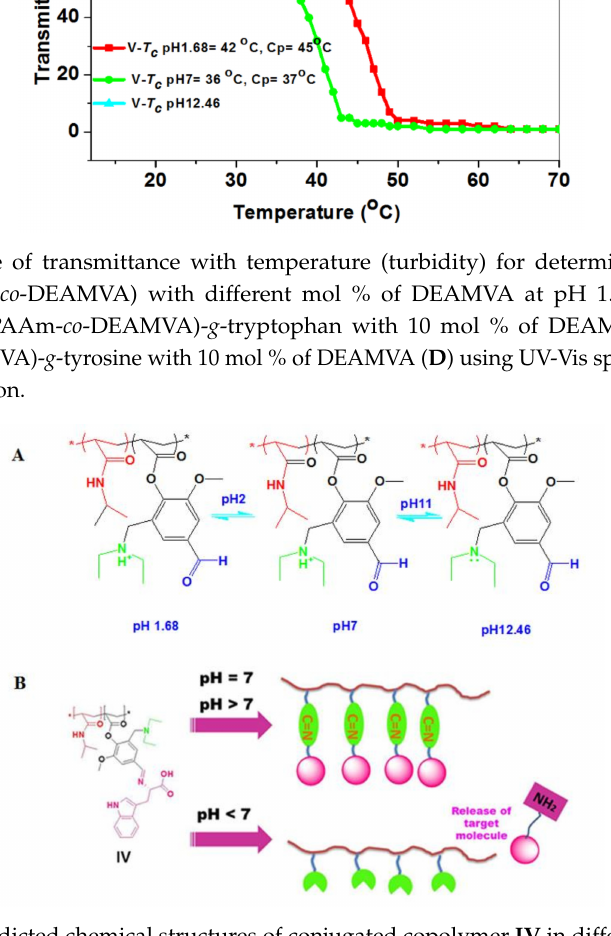
Figure 11. The predicted chemical structures of conjugated copolymer IV in different pH solution.